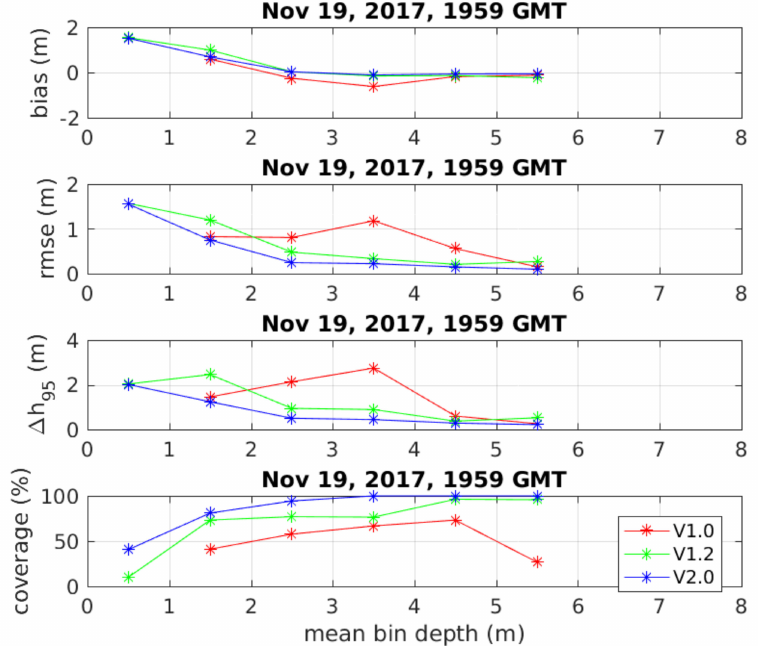
Figure 9. cBathy performance statistics for 19 November 2017, partitioned by depth. Values are plotted at the mean depth for each bin. No survey depths greater than 6 m were observed for this